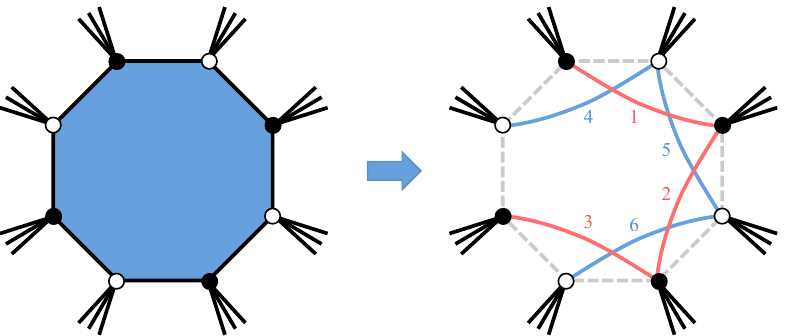
Figure 23. Backreaction of an instanton on an octagonal face of the dimer, i.e. k =